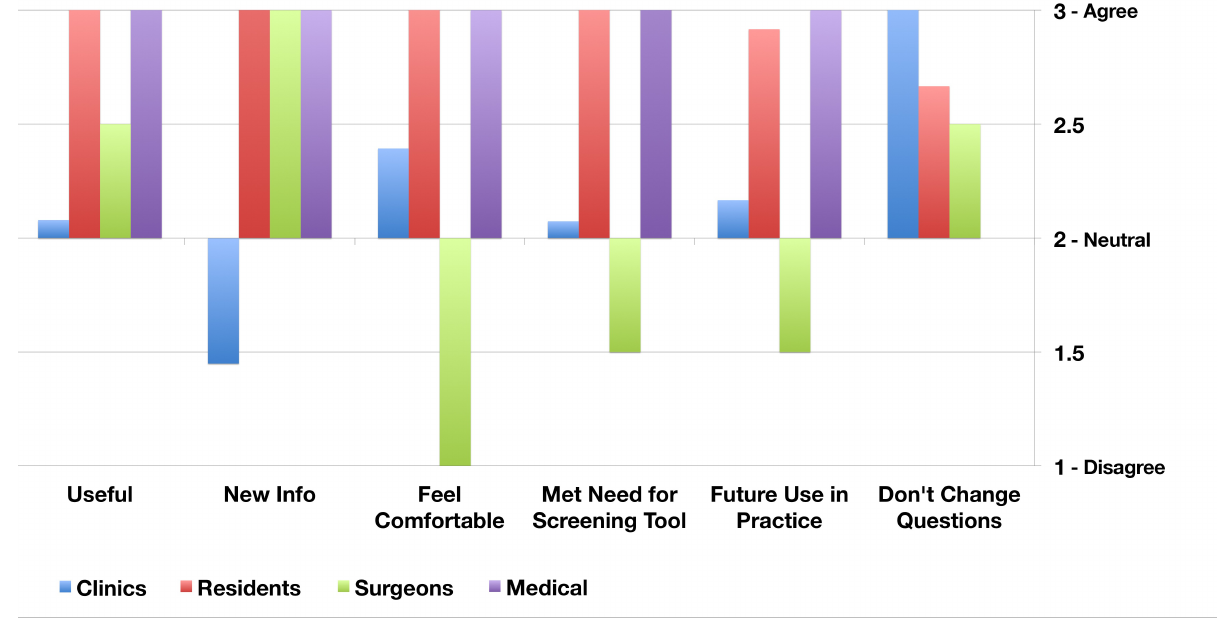
Figure 6. Health care provider perception of